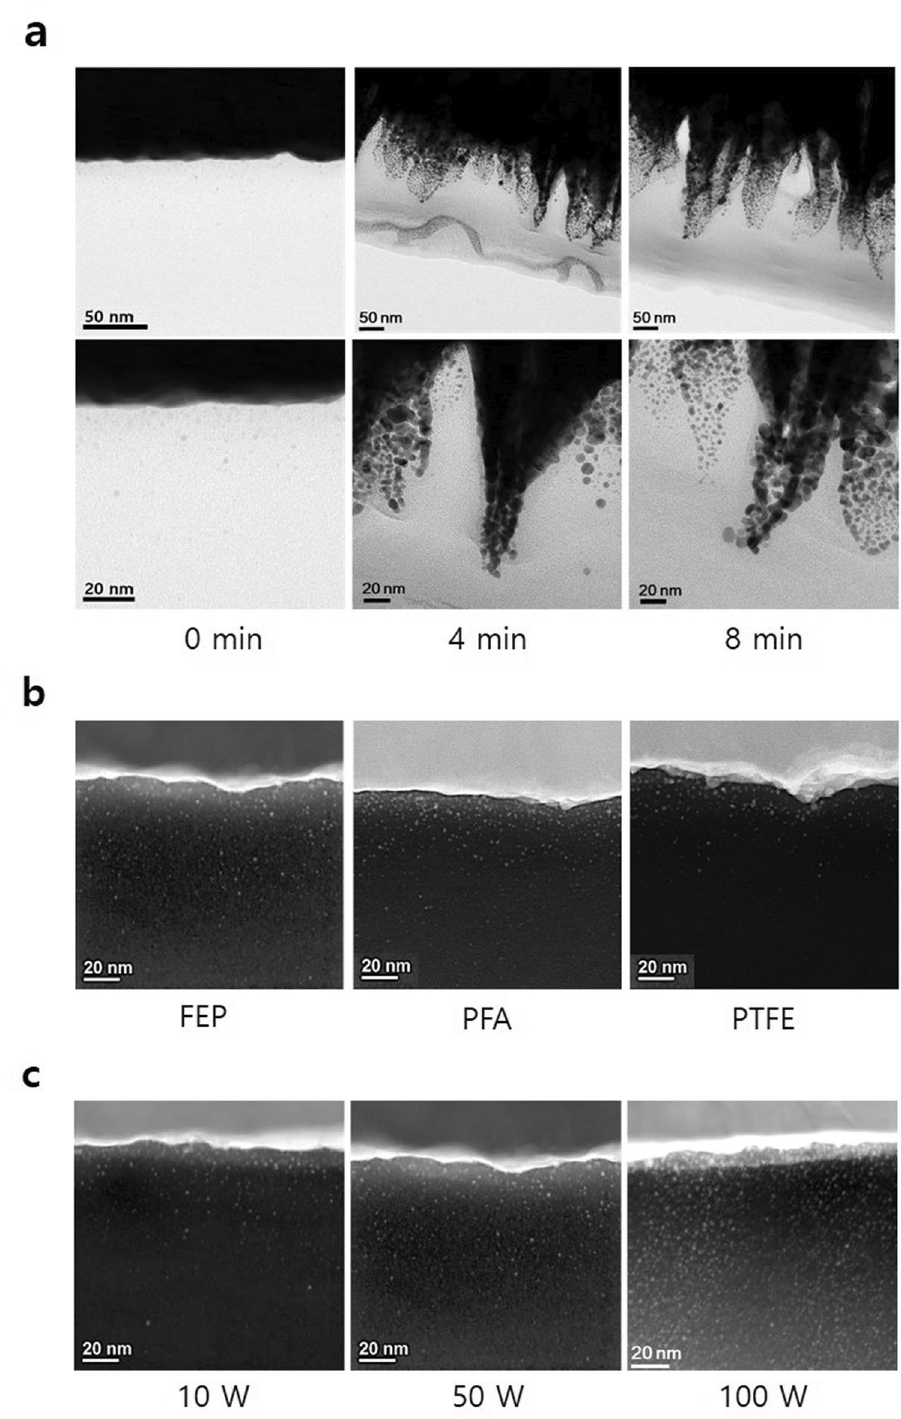
Figure 5. ( a ) Cross-sectional transmission electron microscopy (TEM) images of the Au-FEP interface with respect to plasma treatment time. The FEP was plasma treated at an RF power of 40 W, and Au was deposited at an RF sputtering power of 50 W. ( b ) Cross-sectional STEM images of the Au-FEP, Au-PFA, and Au-PTFE interfaces. Fluoropolymers did not undergo plasma treatment, and Au was deposited at an RF sputtering power of 50 W. ( c ) Cross-sectional STEM images of an Au-FEP interface with respect to the RF sputtering power. All images are of a 127-μm thick FEP